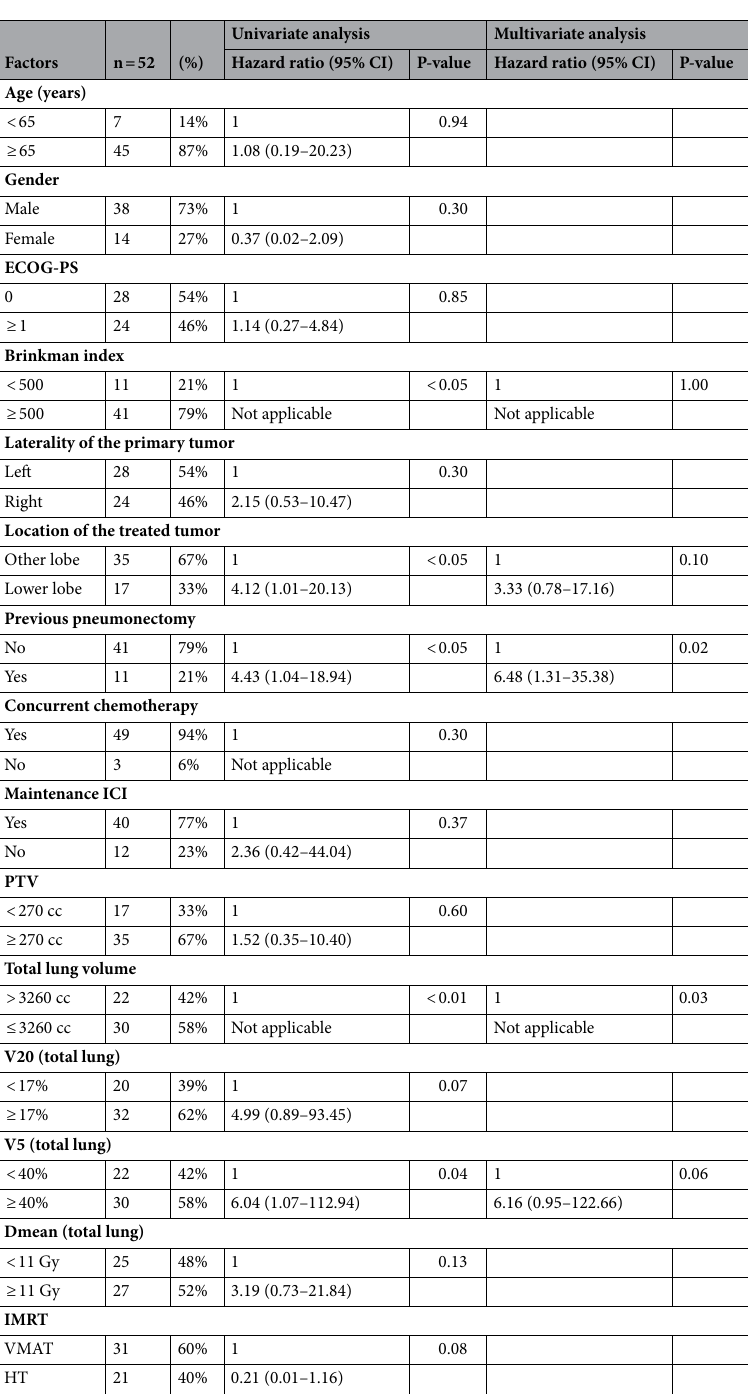
Table 3. Univariate and multivariate analyses for occurrence of grade ≥ 3 radiation pneumonitis. CI confidence interval, ECOG-PS Eastern Cooperative Oncology Group performance status, ICI immune checkpoint inhibitor, PTV planning target volume, V20 lung volume receiving a dose of ≥ 20 Gy, V5 lung volume receiving a dose of ≥ 5 Gy, Dmean mean dose, IMRT intensity-modulated arc therapy, VMAT volumetric modulated arc therapy, HT helical